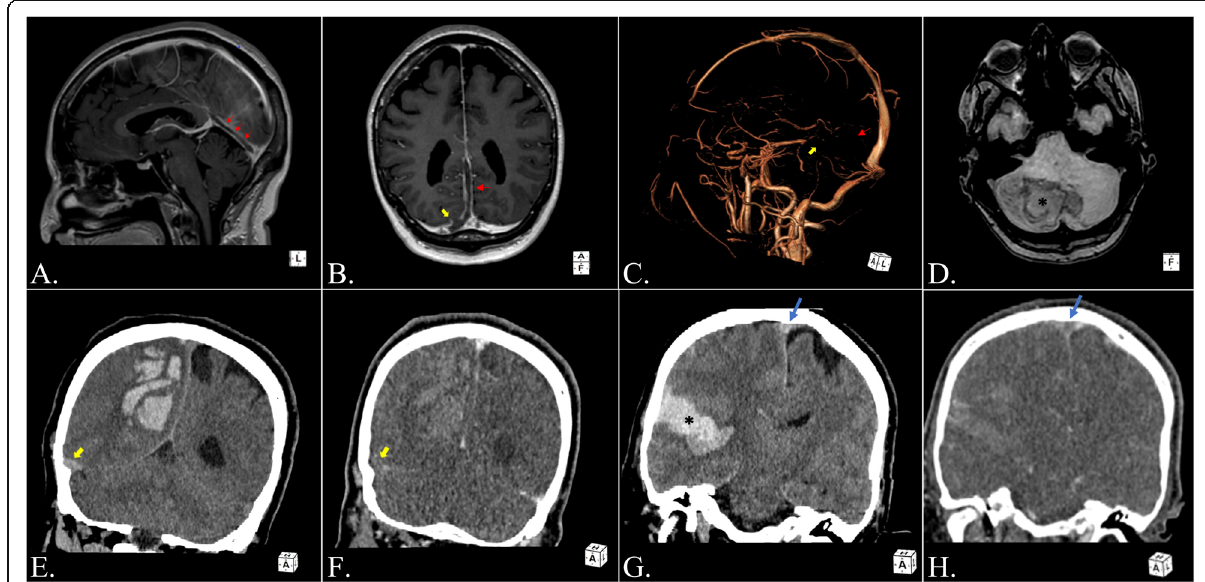
Fig. 1 Neuroradiological findings. Patient 1: A , D magnetic resonance imaging (MRI) examination. A , B Sagittal and coronal contrast-enhanced T1-weigthed images depict SS (red arrows) and right TS (yellow arrows) extensive thrombosis with filling defect inside the vessels. C Phase- contrast MRI angiography (PCA) with volume rendering technique shows lack of venous flow in SS (red arrow) and right TS (yellow arrow). D Susceptibility-weighted (SWI) follow-up MRI examination shows acute bilateral cerebellar hemisphere hematoma, prevalent on the right side (asterisk). Patient 2: E , H brain computed tomography (CT scan examination) at clinical onset. E Coronal unenhanced CT scan depicts large right parietal hematoma and ipsilateral TS hyperdensity ( “ Dense clot Sign ” ), indicated by yellow arrow. F Coronal enhanced CT scan shows lack of opacization of thrombosed right TS (yellow arrow). G Coronal unenhanced CT scan depicts right temporal hematoma (asterisk) and “ Dense clot Sign ” at SSS (blue arrow). H Coronal enhanced CT scan shows triangular area of enhancement with a relatively low-attenuating center ( “ Empty delta Sign ” ) at thrombosed SSS (blue arrow). Straight sinus (SS), superior sagittal sinus (SSS), transverse sinus